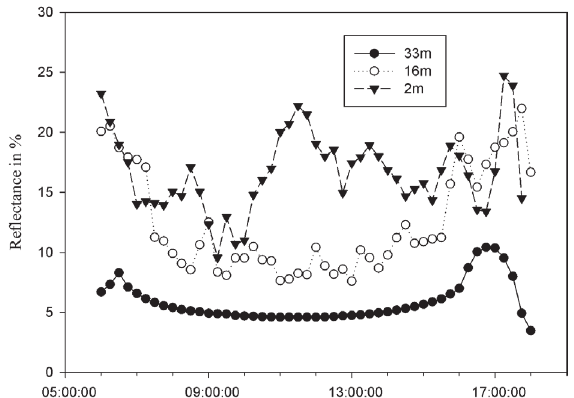
Figure 6 - Mean hourly PAR reflectance during the dry period within the canopy (16 m and 2 m) and above the canopy (33